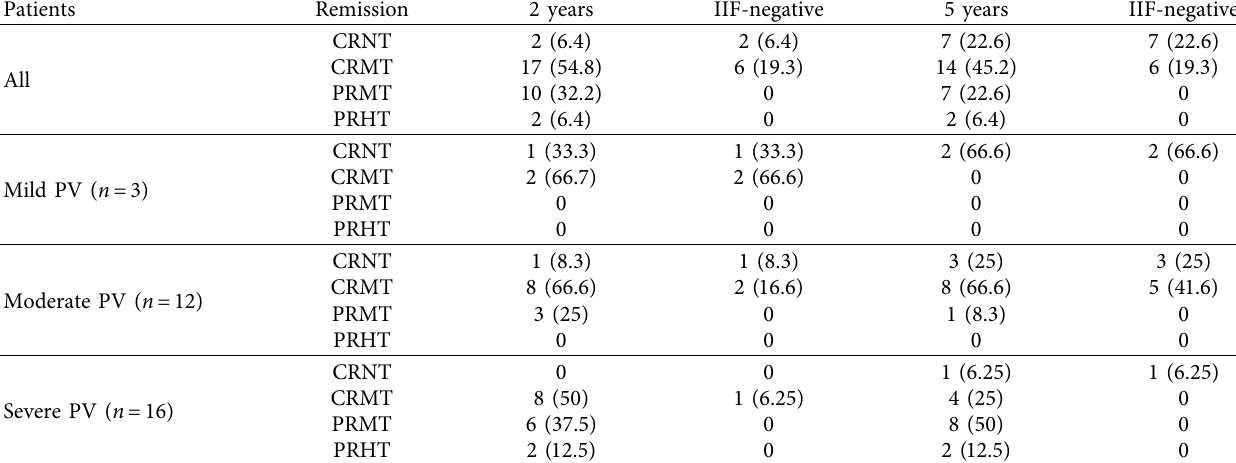
Table 3: Remission rates in patients with pemphigus vulgaris (PV) and indirect immunofluorescence (IIF) results obtained after 2 and 5 years of